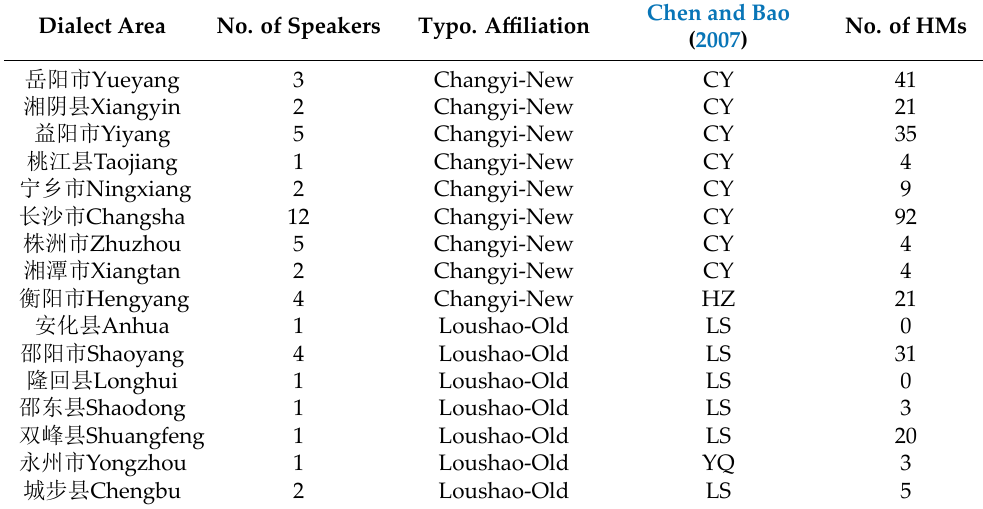
Table 2. Speakers and Dialect Areas in the Sample. Dialect